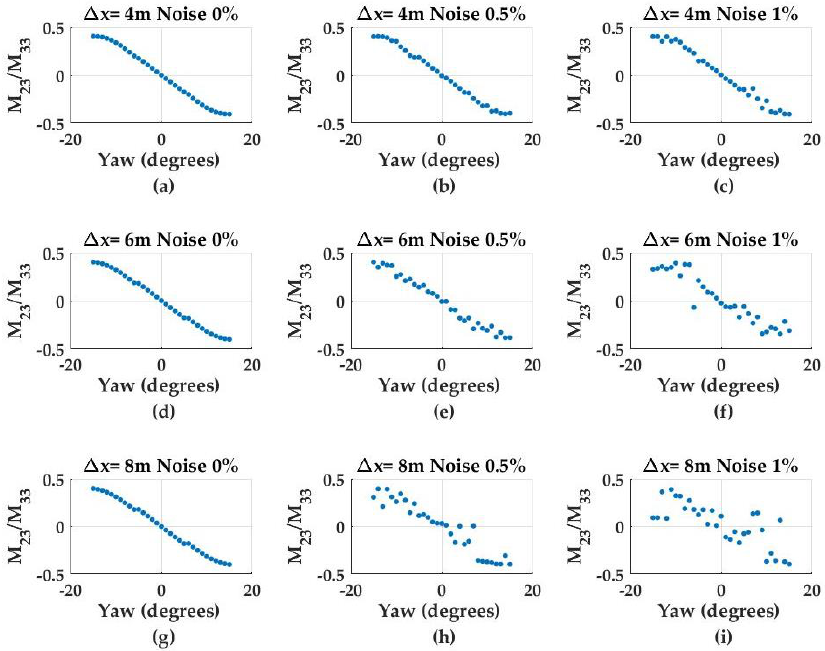
Figure 5. M 23 M 33 ratio values for changing yaw angles at varying x -axis offsets (4 m, 6 m, and 8 m) and noise levels (0%, 0.5%, and 1.0%) and with y - and z -axis offsets at zero: ( a ) ∆ x = 4 m, noise = 0%; ( b ) ∆ x = 4 m, noise = 0.5%; ( c ) ∆ x = 4 m, noise = 1%; ( d ) ∆ x = 6 m, noise = 0%; ( e ) ∆ x = 6 m, noise = 0.5%; ( f ) ∆ x = 6 m, noise = 1%; ( g ) ∆ x = 8 m, noise = 0%; ( h ) ∆ x = 8 m, noise = 0.5%; and ( i ) ∆ x = 8 m, noise = 1%.